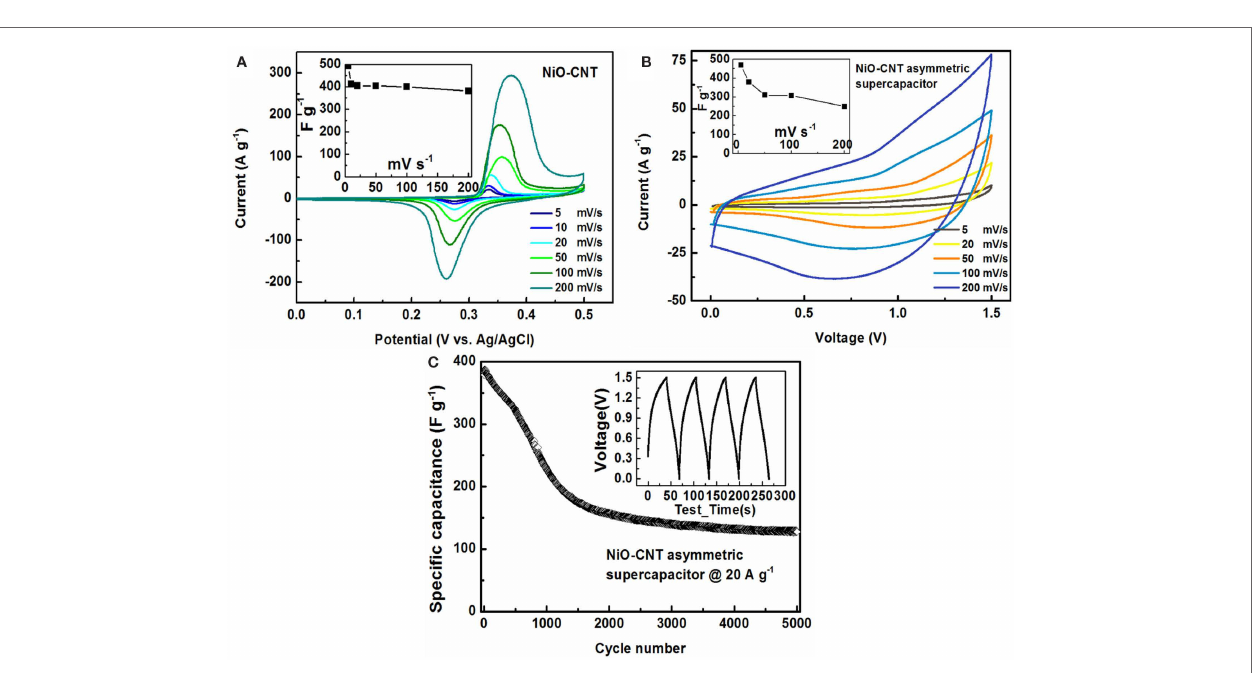
specific capacitance vs . scan rates. (c) Galvanostatic charge/discharge cyclic performance of the asymmetric supercapacitor within a voltage window of 1.5 V at a current density of 20 A g − 1 . Inset: charge/discharge